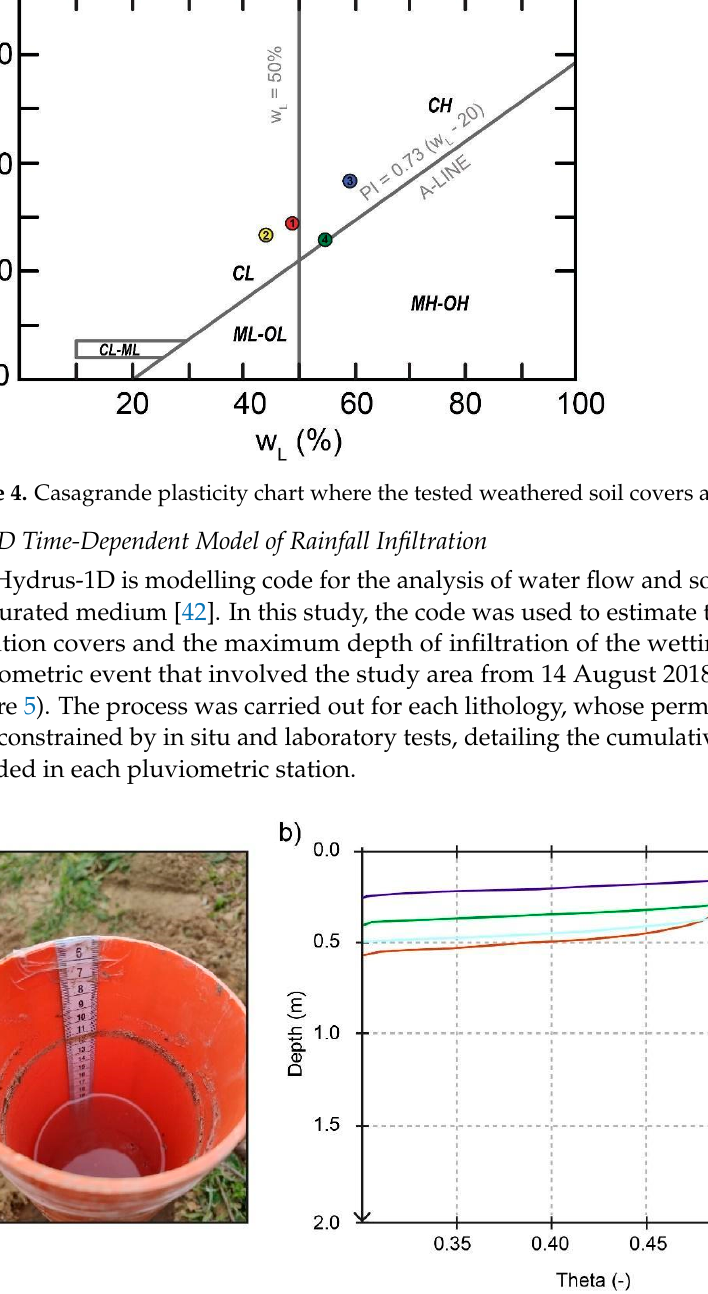
Figure 5. ( a ) In situ Lefranc tests were carried out in the soil cover to constrain the permeability